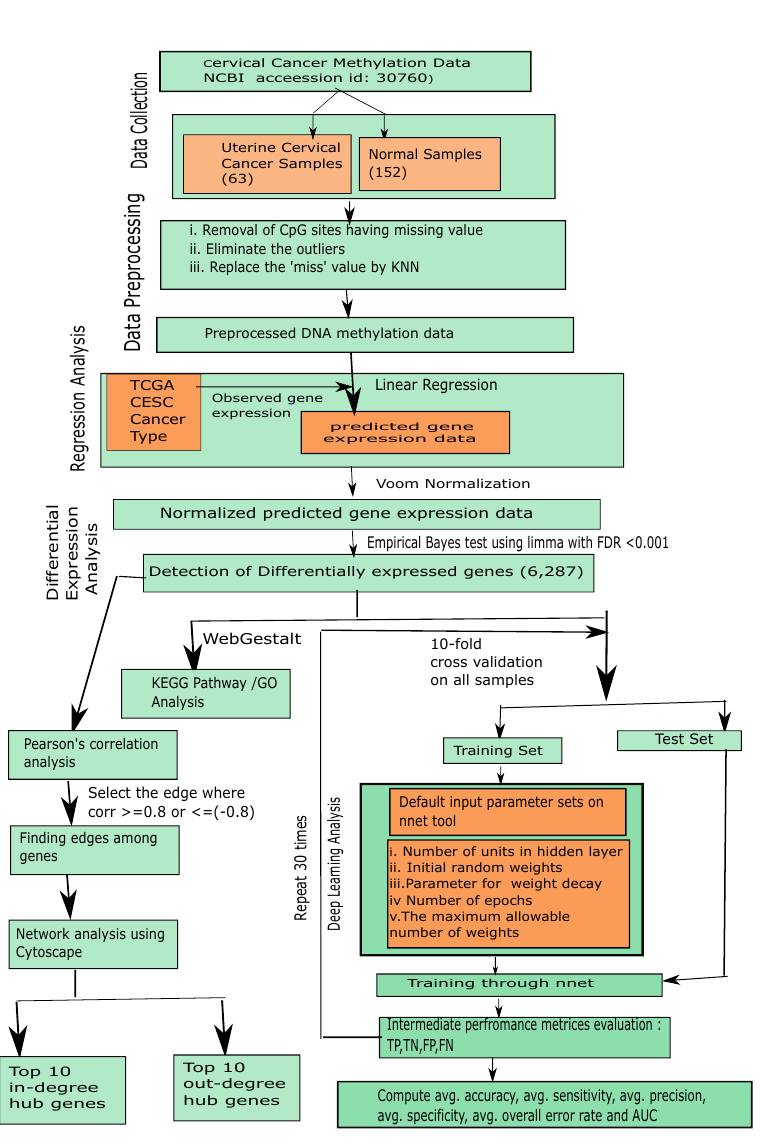
Figure 1. Flowchart of the proposed